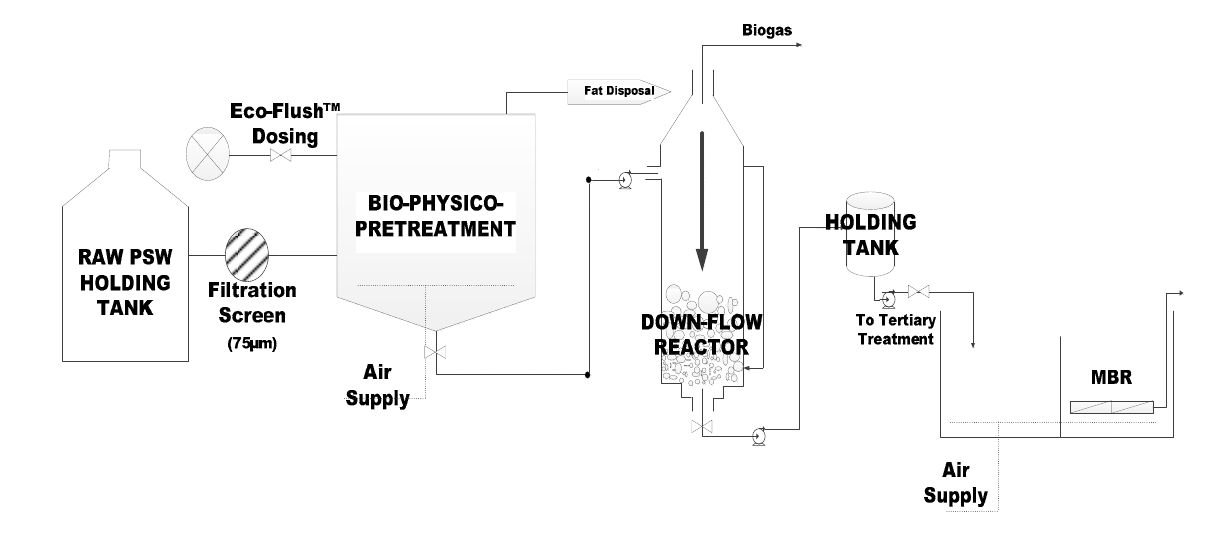
Figure 2. Process Flow Diagram of the Treatment Plant.